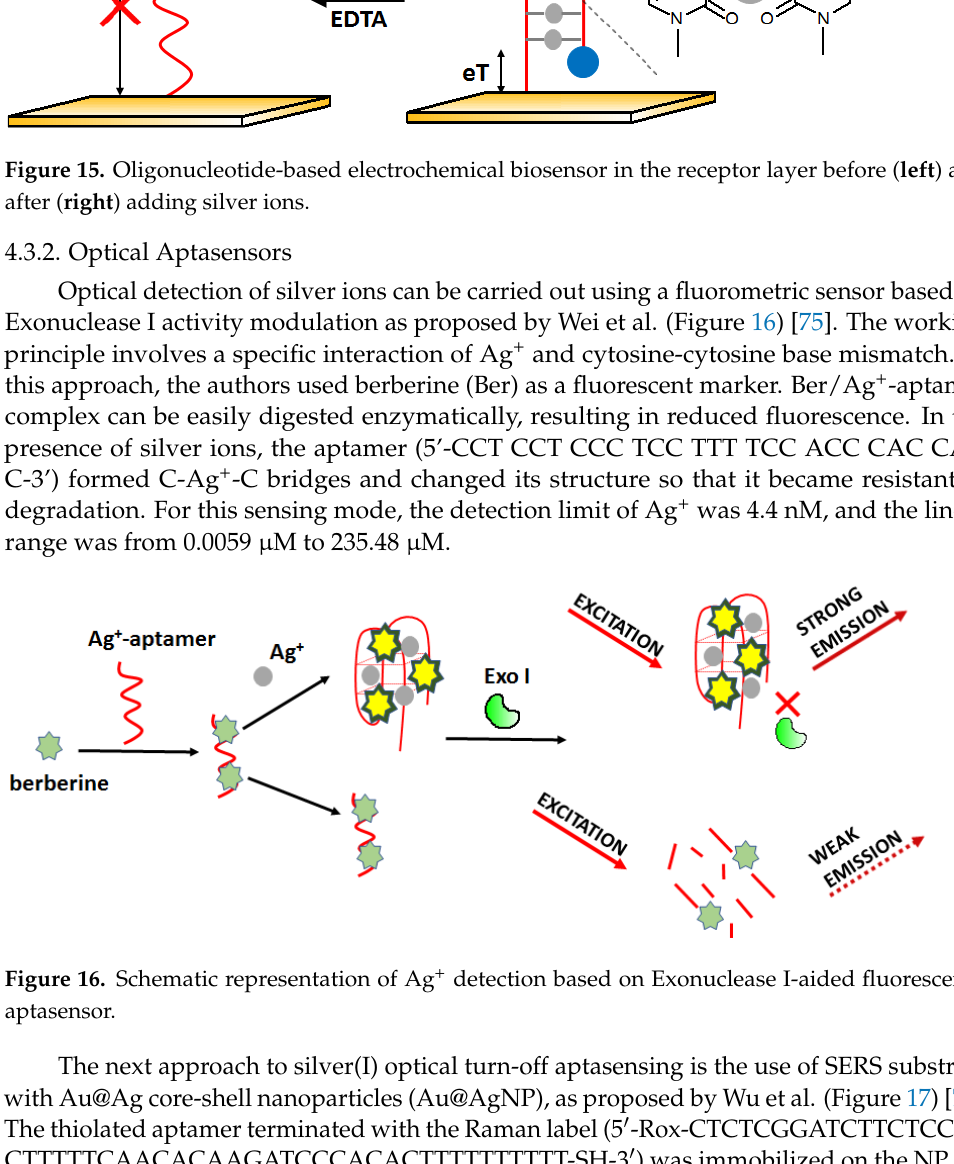
Figure 15. Oligonucleotide-based electrochemical biosensor in the receptor layer before ( left ) and after ( right ) adding silver ions.